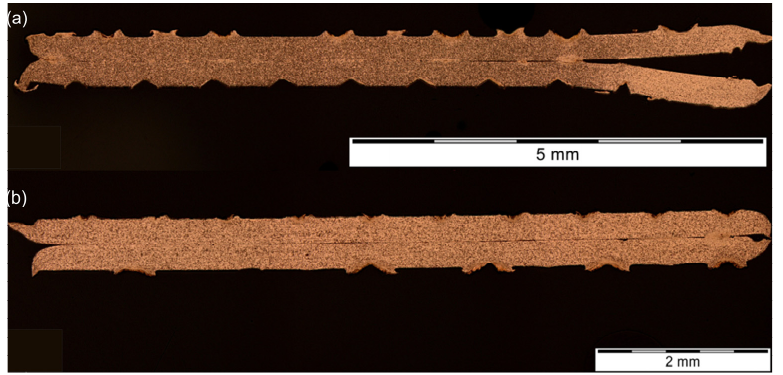
Figure 15. Metallographic images (×50) of etched Cu–Cu welds with t = 0.3 mm for increasing weld- ing time: ( a ) 1.5 s; ( b ) 3.5 s. welding time: ( a ) 1.5 s; ( b ) 3.5